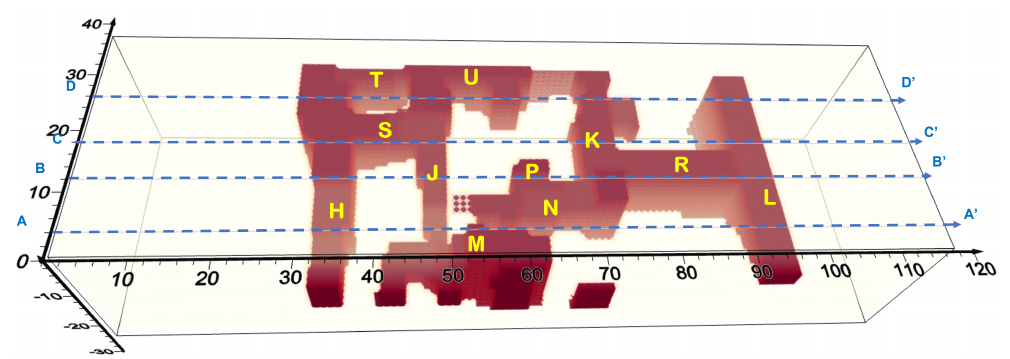
Figure 11. Perspective view of the simplified 3D resistivity model of the Foderà Quarry obtained by RES3DMOD™ software. The yellow letters indicate the main rooms and tunnels. The blue dashed lines indicate the traces of the simulated 2D